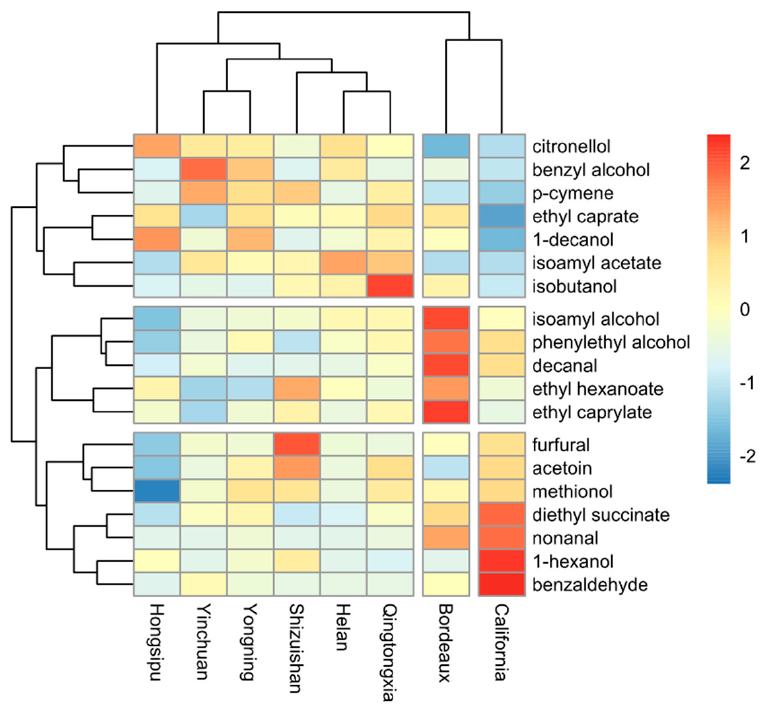
Figure 4. HCA (hierarchical cluster analysis) of wines based on volatile compounds from the six sub-regions of Ningxia, Bordeaux, and